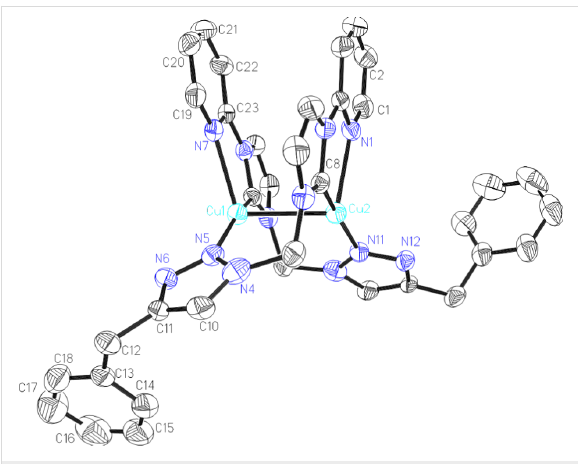
Figure 3: ORTEP drawing of [Cu 2 (L 3 ) 2 ](PF 6 ) 2 ( 4 ). Thermal ellipsoids are drawn at the 30% probability level. Hydrogen atoms and anions have been removed for clarity. Selected bond distances (Å) and angles (°): Cu1-C26 1.888(6), Cu1-N5 1.912(5), Cu1-N7 2.289(5), Cu1-Cu2 2.6413(12), Cu2-C8 1.899(5), Cu2-N11 1.922(4), Cu2-N1 2.311(5); C26-Cu1-N5 159.2(2), C26-Cu1-N7 79.0(2), N5-Cu1-N7 116.65(19), C26-Cu1-Cu2 72.49(17), N5-Cu1-Cu2 113.20(15), N7-Cu1-Cu2 105.13(12), C8-Cu2-N11 166.1(2), C8-Cu2-N1 78.6(2), N11-Cu2-N1 110.5(2), C8-Cu2-Cu1 70.45(16), N11-Cu2-Cu1-116.14(15), N1- Cu2- Cu1 102.03(13).